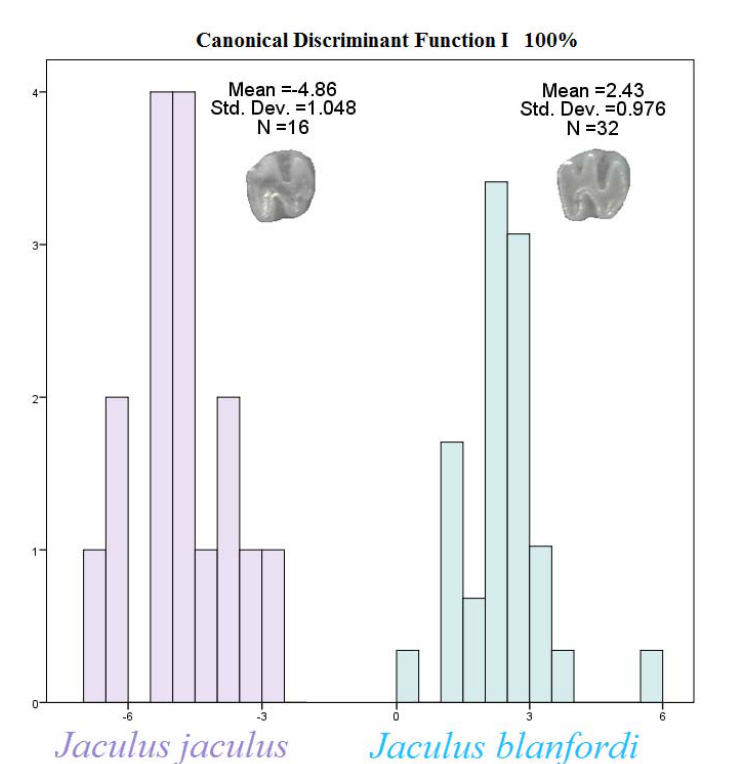
F IGURE 7. The projection of two species on function of CDA according to the shape of 2 nd lower molar. Horizontal axis explains 100 % of whole